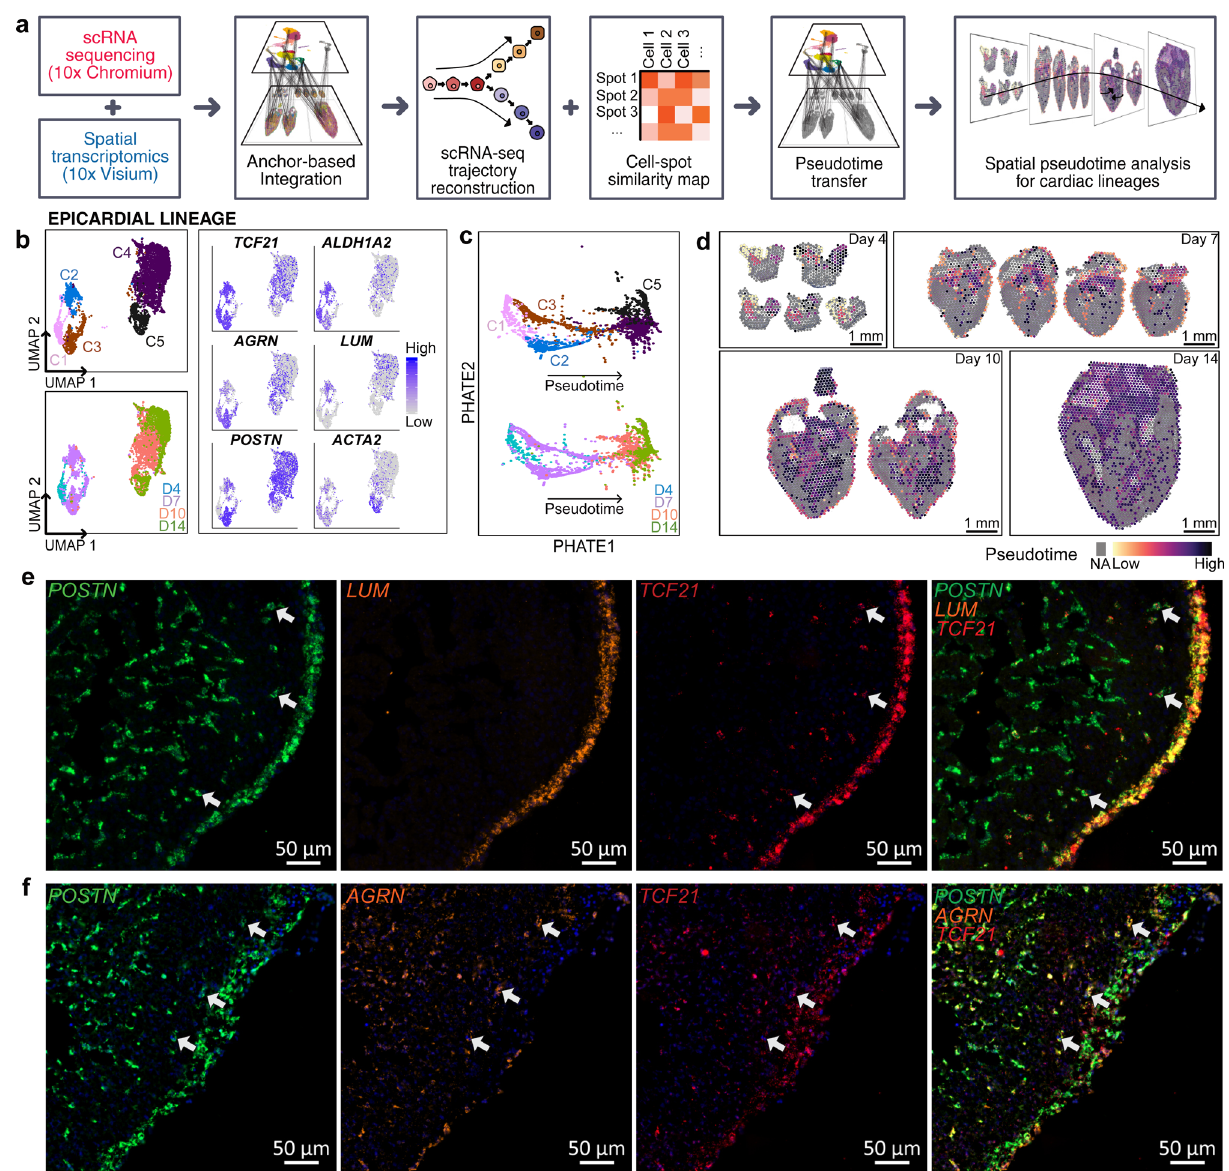
Fig. 2 Spatiotemporal lineage analysis identi fi es heterogeneity in cardiac progenitor cells. a Overview of analysis pipeline for trajectory reconstruction for scRNA-seq and spatial RNA-seq data. b UMAP projection of single-cell transcriptomes from individual epicardial lineage cells clustered by gene expression and colored by cell type (left-top) and developmental stage (left-bottom). Feature plots showing expression of gene markers for individual epicardial lineage cells (right). c Epicardial lineages visualized by PHATE and labeled by cell type (top) and development stage (bottom). d Spatially resolved spatial RNA-seq spot pseudotime for epicardial lineage across developmental stages. Spot pseudotime was estimated using a similarity map between scRNA-seq cells and spatial RNA-seq spots. e single-molecule FISH of Day 7 (HH31) ventricular free walls stained for POSTN (green), TCF21 (red), and DAPI (blue) with LUM (orange). f Single-molecule fl uorescent in situ hybridization of Day 7 (HH31) ventricular free walls stained for POSTN (green), TCF21 (red), and DAPI (blue) with AGRN (orange). The Blue channel is DAPI. Representative images of three to four biological